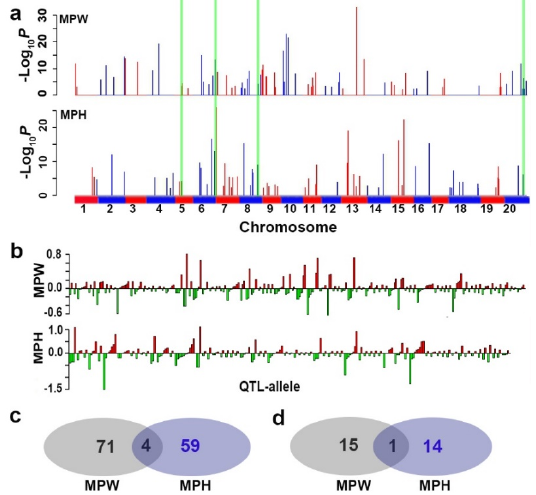
Figure 1. The detected QTL conferring two drought tolerance indicators. ( a ) The detected drought tolerance QTL for the two indicators located on chromosomes over the whole genome. The probability −Log 10 P value indicates the significance level of the corresponding QTL. The vertical green bars spanning multiple graphs denote the four shared QTL/markers between the two indicators. ( b ) The allele effects of the DT QTL for MPW and MPH; the red and green bars indicate the positive and negative alleles, respectively. ( c ) and ( d ), the Venn-Diagrams of the whole and LC-major QTL for the two indicators, respectively. Table 4. The detected QTL-allele system that confers drought tolerance in the CCSP.